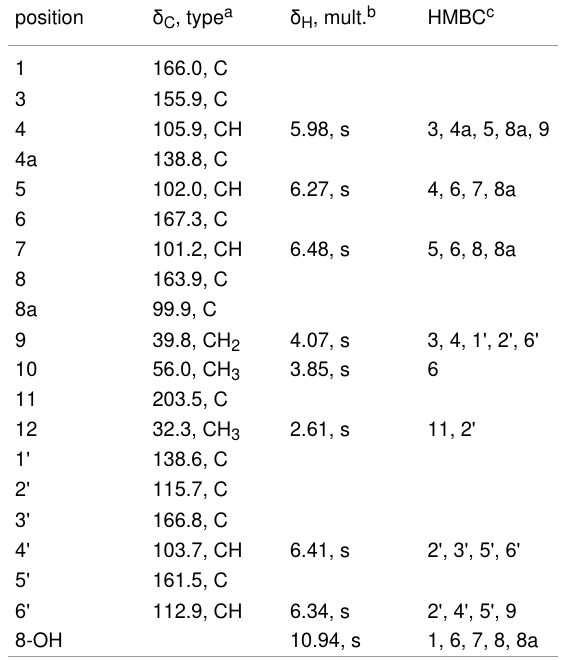
Table 3: NMR spectroscopic data for karimunone B ( 2 ) in CDCl 3 .